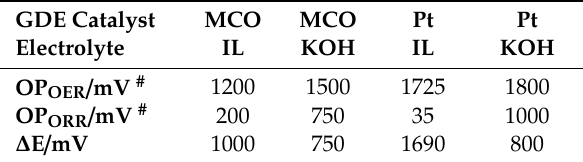
Table 3. List of onset potential values of different GDEs for OER/ORR in either 7 M KOH or ChAcO +